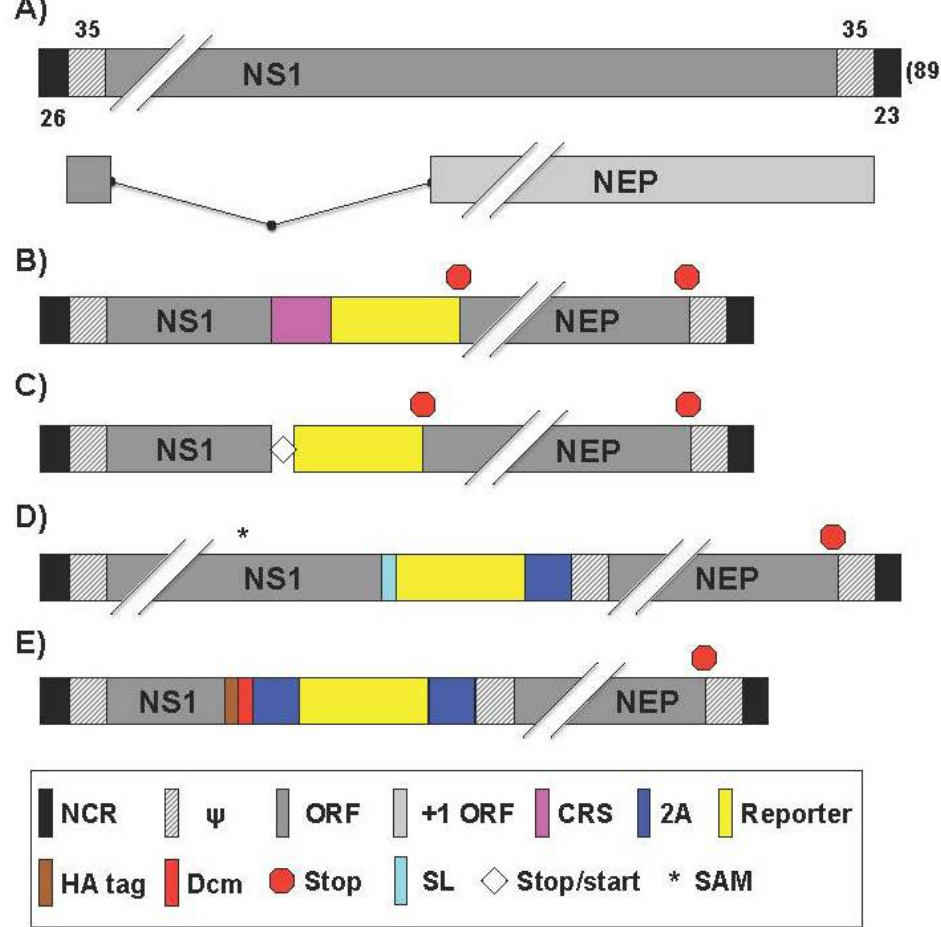
Figure 7. NS reporter influenza A viruses: Schematic representation of the NS segment from WT ( A ) and reporter ( B – E ) influenza A viruses as described in Figure 1. Influenza A WT NS gene